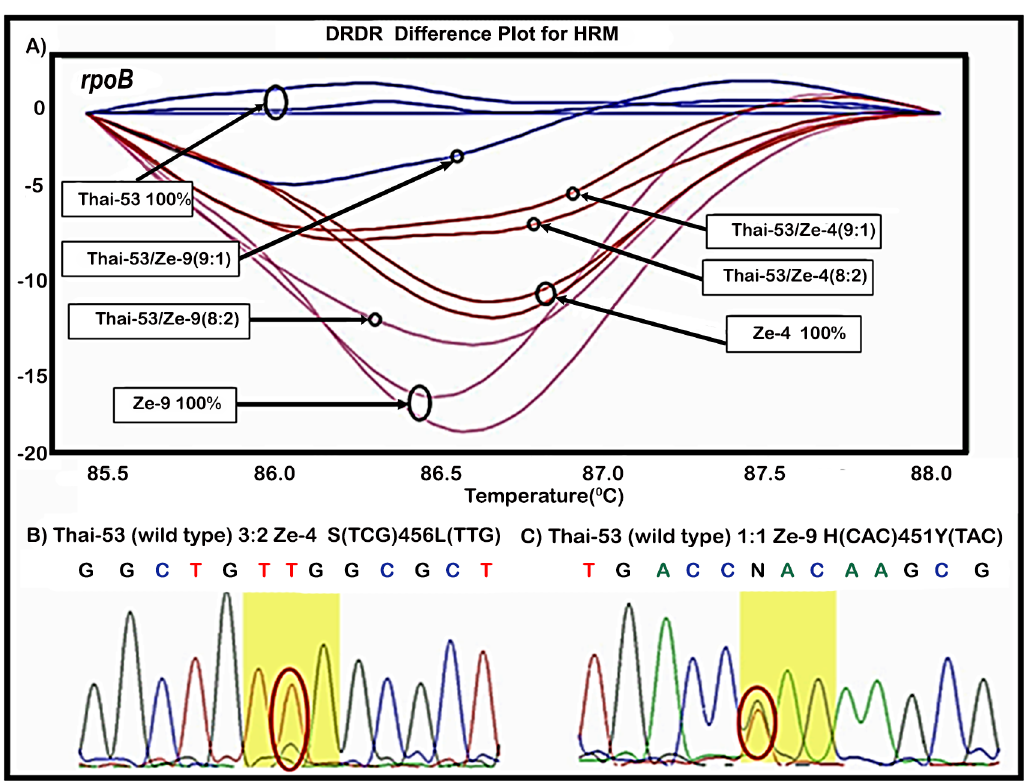
Fig 4. Determination of RMP-resistant mutant allele detection limit in a mixture of wild-type/RMP-resistant mutant DRDRs using M . leprae qPCR-HRM DST. A) Differenceplot graphic displaysof the post-PCR HRM melting curve analysisof the rpoB drug resistancedetermining region(DRDR) of wild-type(Thai-53) and RMP-R strains (Ze-4 and Ze-9) and mixtures of Thai-53 and these RMP-R mutants; B) PCR-DNA sequencing of the rpoB DRDRs of 3:2 ratio of Ze-4; and C) PCR-direct DNA sequencing of the rpoB DRDRs of 1:1 ratio of Ze-9. Yellow highlights identify codon where mutations were observed.